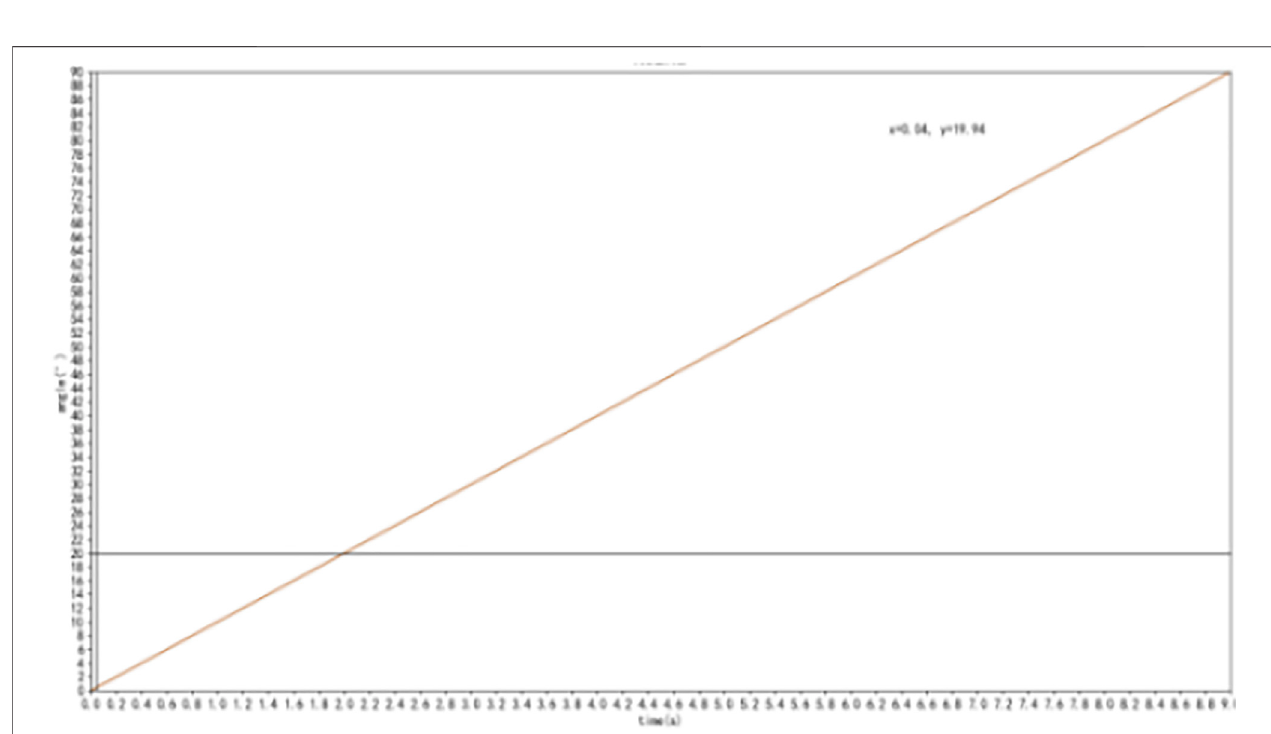
FIGURE 8 | Time motion curve of angle